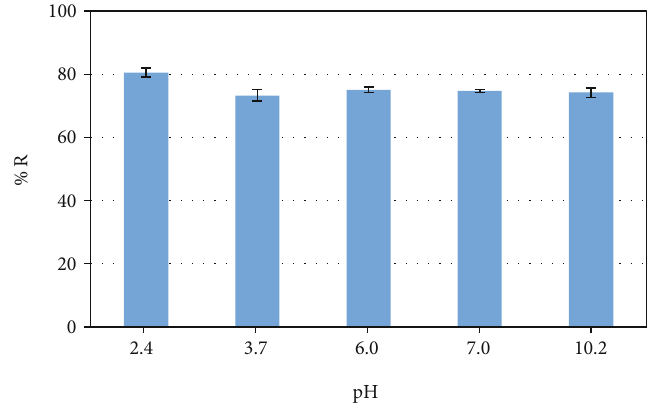
Figure 2: The e ff ect of adsorbent dosage on removing MB dye from solution using BC500 (room temperature, unadjusted pH, C and contacttime = 3h